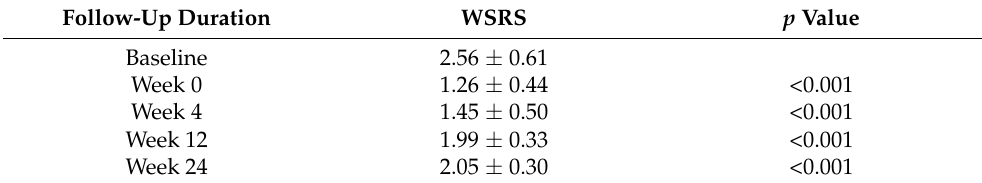
Figure 2. The proportion of WSRS score improvements at week 0, 4, 12, and 24 from baseline. Abbreviations: WSRS = Wrinkle Severity Rating Scale. Table 1. Comparison (with a t -test) of WSRS scores a .